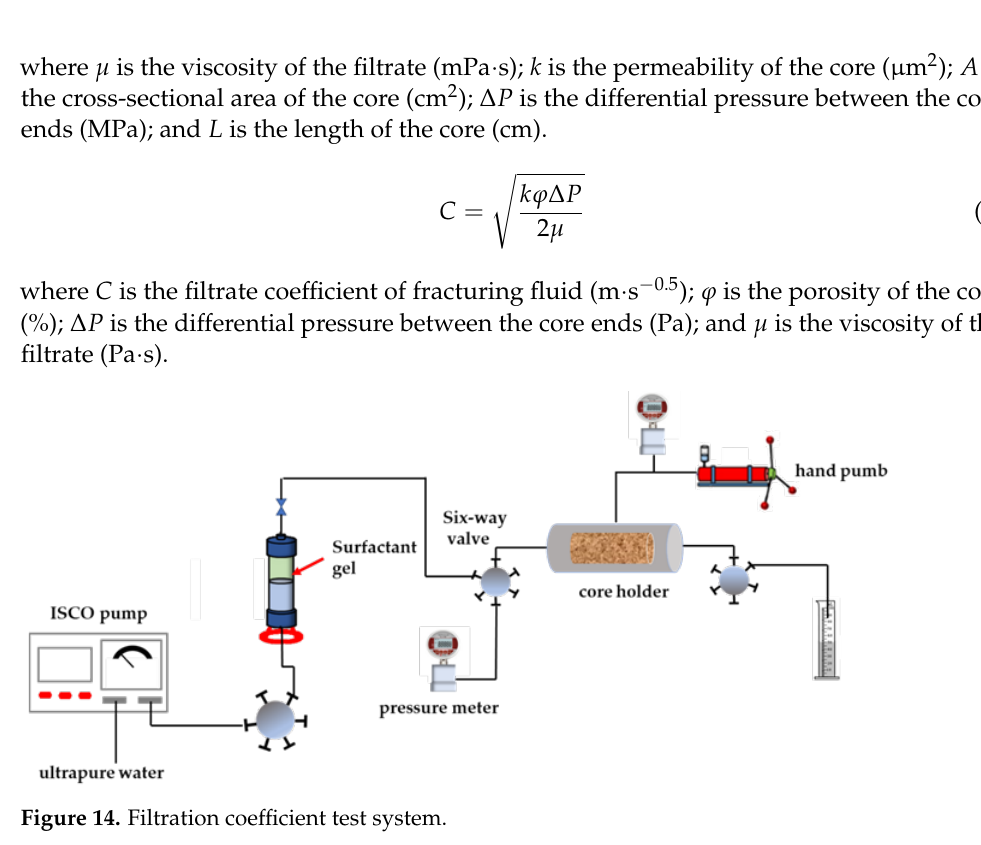
Figure 14. Filtration coefficient test system.